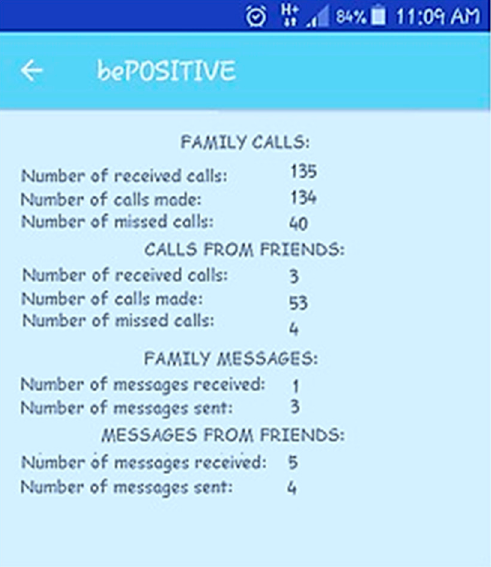
Figure 1. Screen from the bePOSITIVE